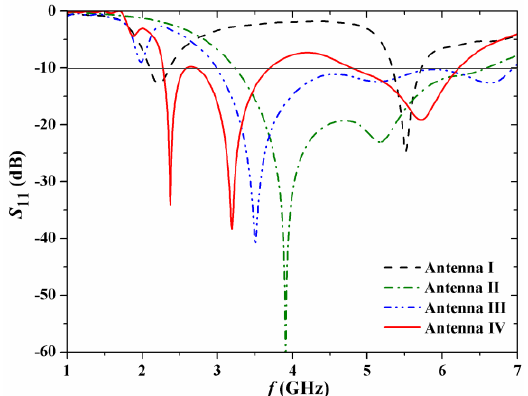
Figure 10. Simulated reflection coefficient of different proposed antenna.